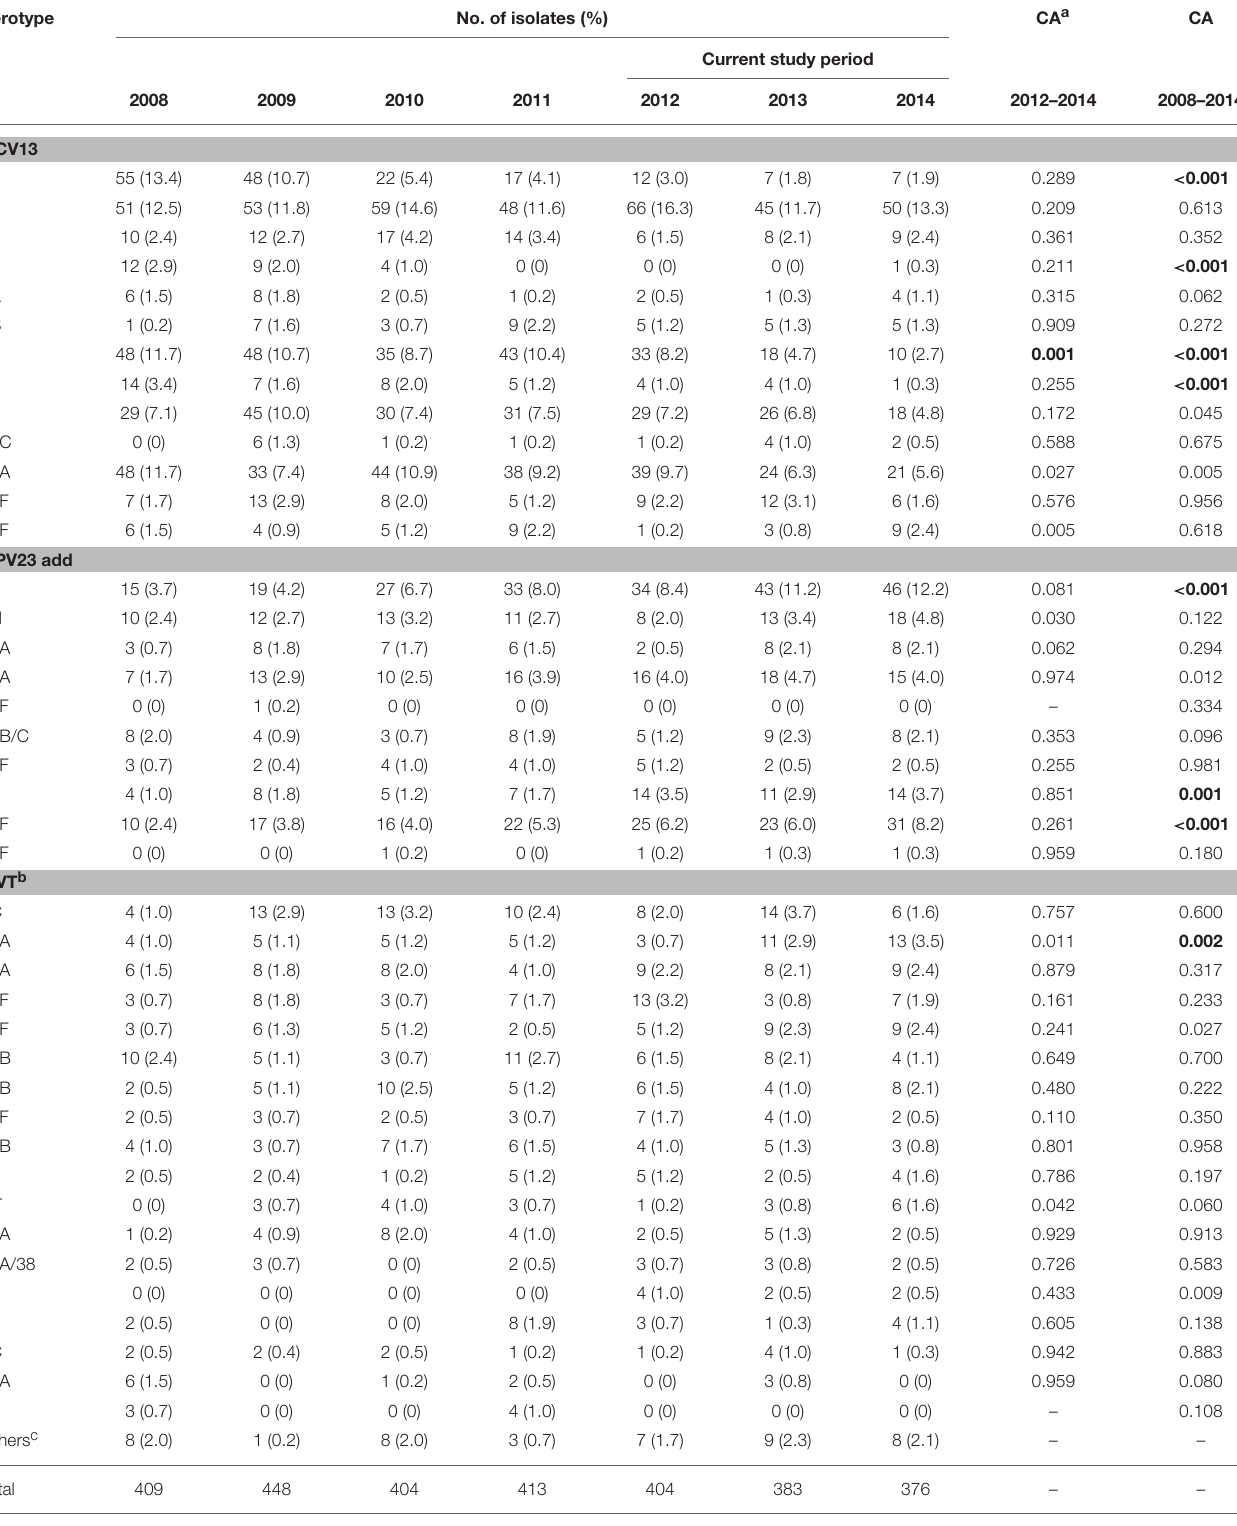
TABLE 1 | Serotypes of the isolates responsible for invasive pneumococcal disease in adult patients ( ≥ 18 years), 2008–2014. Serotype No. of isolates (%) CA